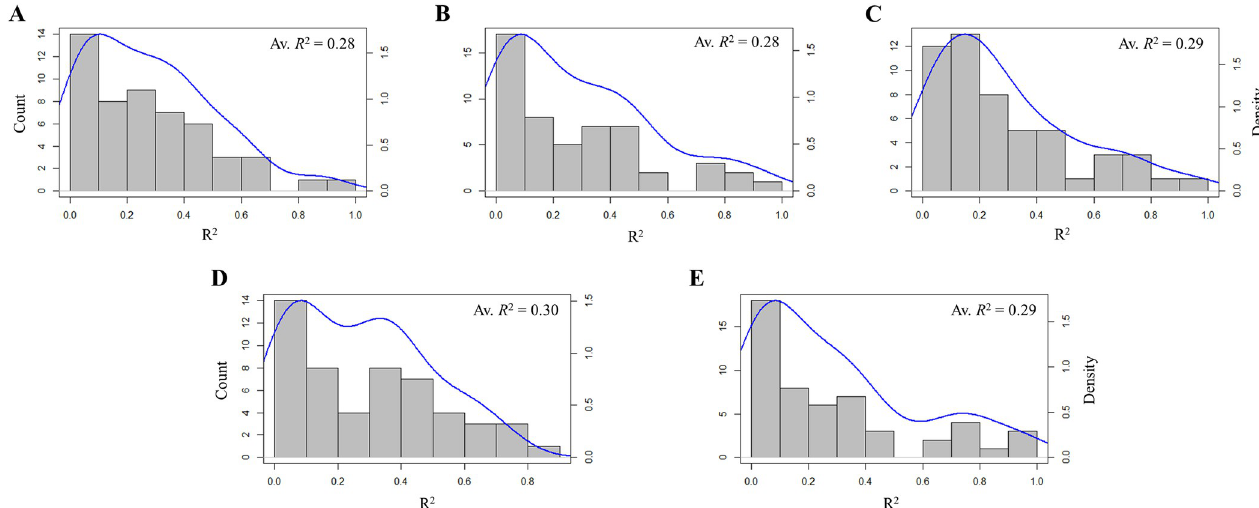
Fig 3. Distribution of predictive performance across individuals for each five factor-based outcome model. (A) extraversion models; (B) agreeableness models; (C) conscientiousness models; (D) stability models; (E) openness to experience models. Reported R 2 values represent the average R 2 across all LOSO fold performances ( N = 54) for each respective